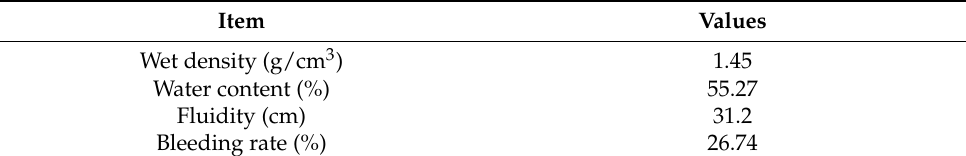
Figure 1. DWS from bored pile in the slurry pool.